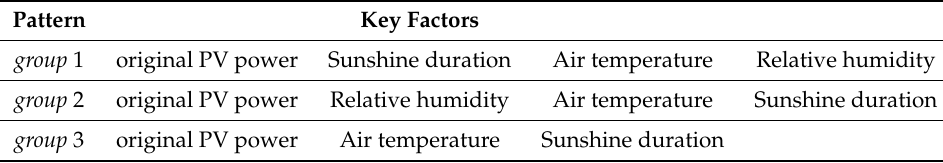
Table 3. The results of variable selection by LARS in